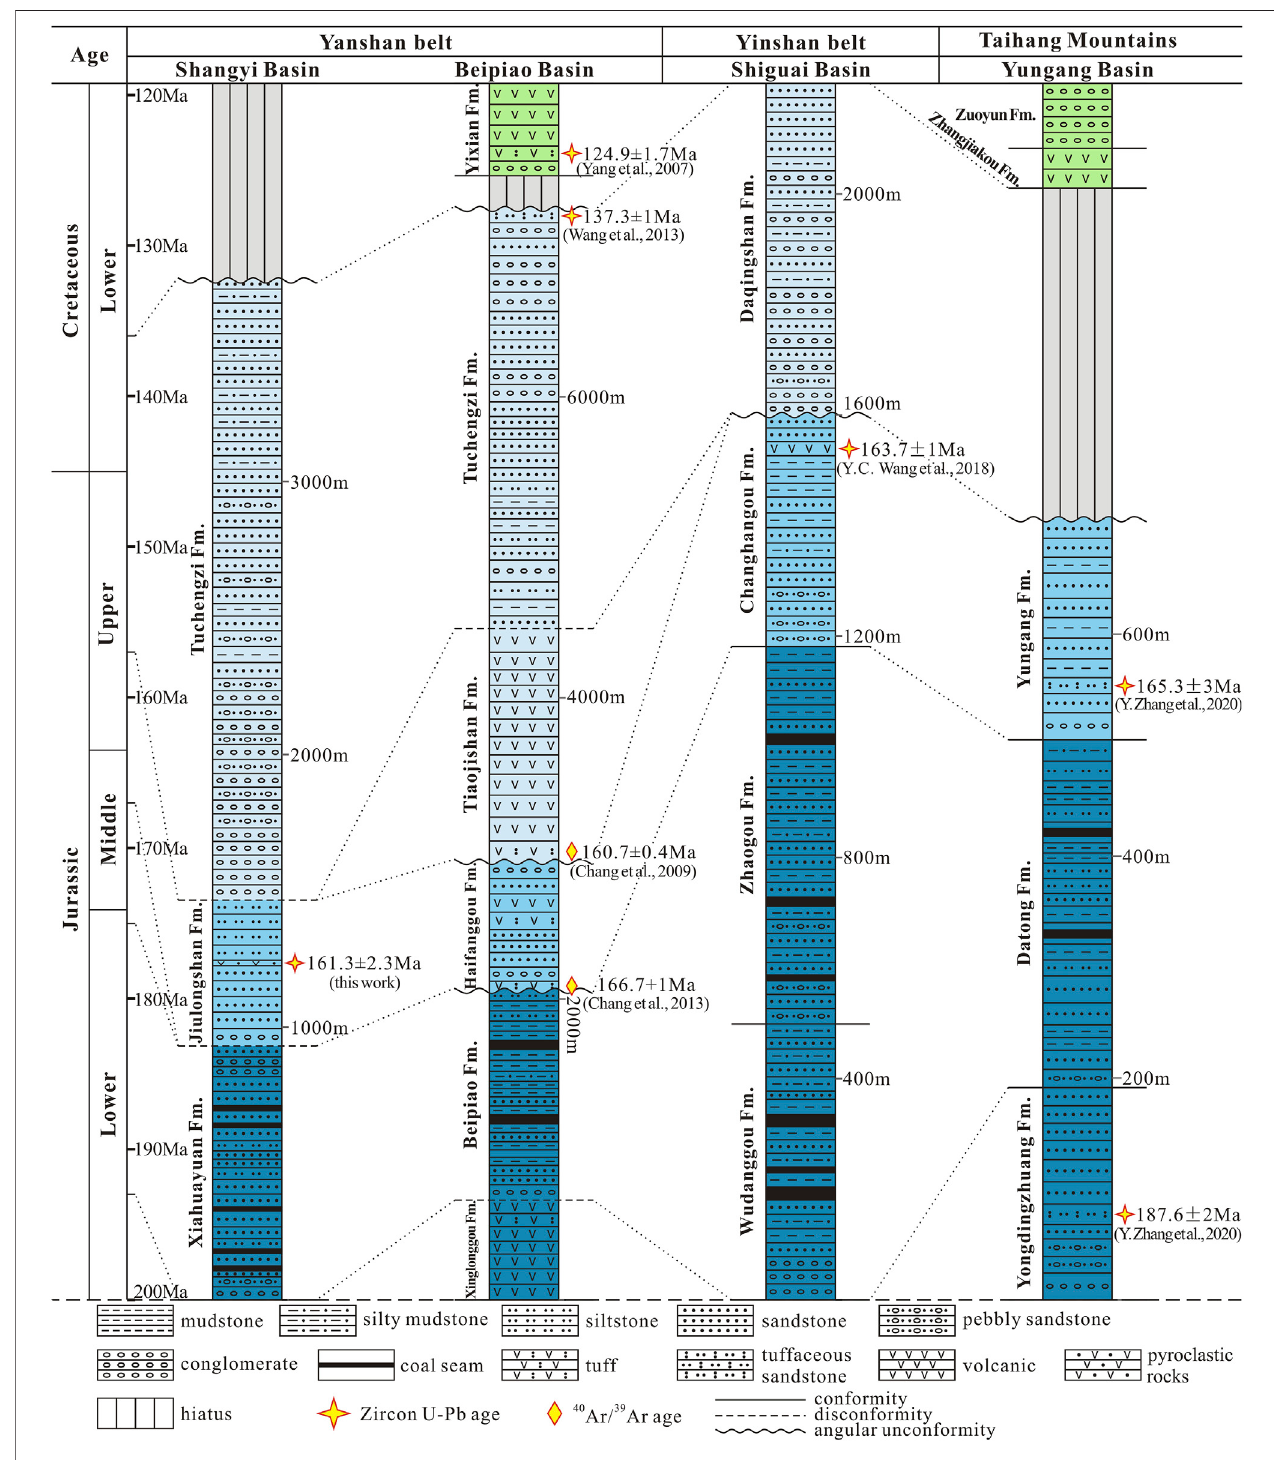
FIGURE 3 | Late Mesozoic stratigraphic units in the Shangyi Basin and its correlation with other typical late Mesozoic basins in the North China Carton. Beipiao, Shiguai,andYungangbasinsweremodi fi edfromJ.Liuetal.(2015),Y.C.Wangetal.(2018)andY.Zhangetal.(2020),respectively.Thegeochronologicaldataofthelate Mesozoic stratigraphic units in the Beipiao Basin were obtained from Yang et al. (2007), Chang et al. (2009, 2013) and Wang et al. (2013).